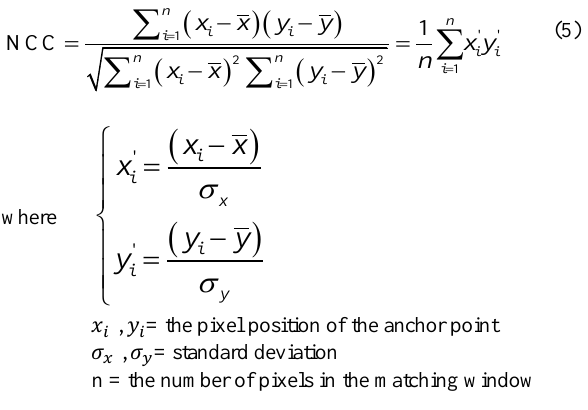
Table1. Test results with